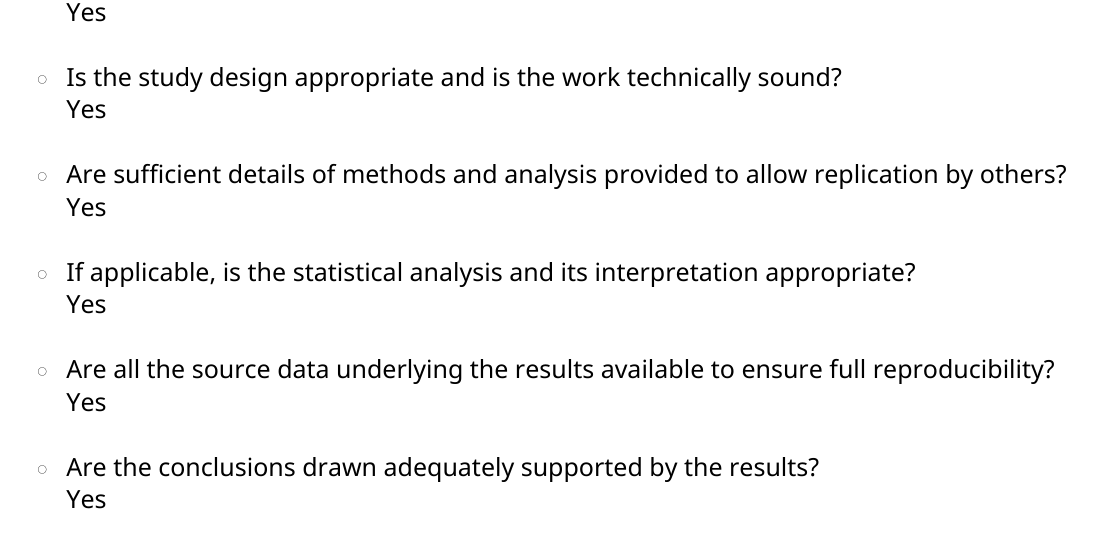
Competing Interests: I collaborated with Professor Taslim on an article titled, Protein-Energy Nutritional Status of Moderately Low Protein Intake-Sago Diets Compared to Sufficiently Protein Intake-Rice Diets in Well-Nourished Lowlanders in Papua,